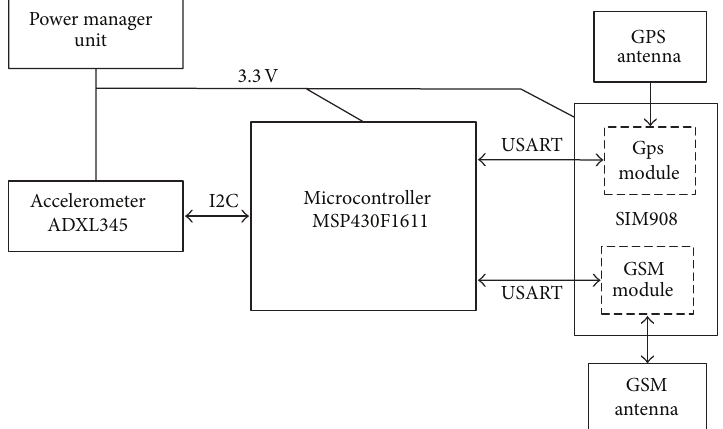
Figure 6: Basic hardware